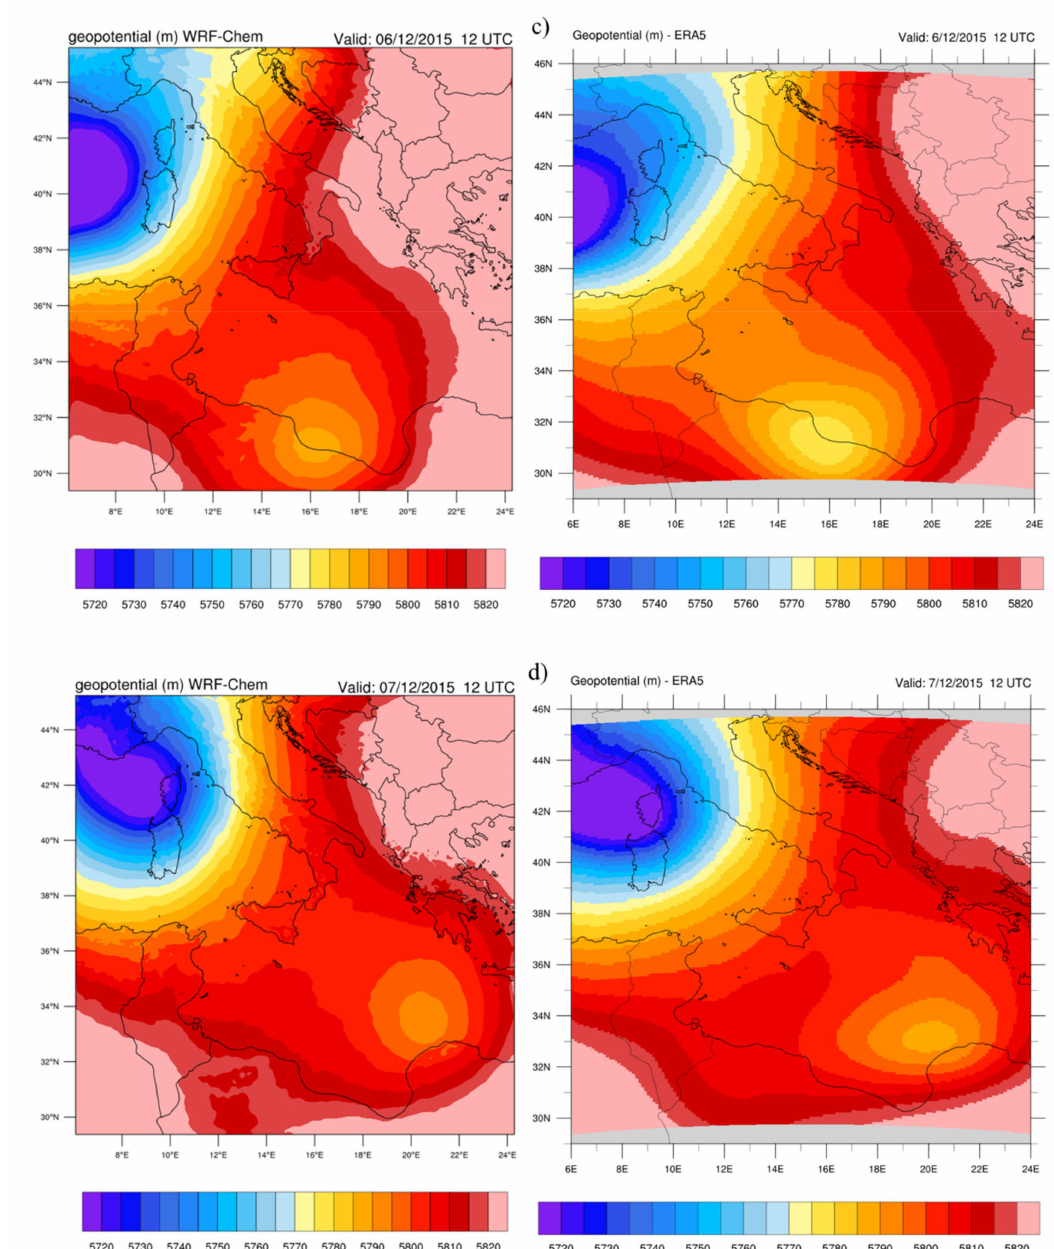
Figure 6. Geopotential height at an atmospheric pressure of 500 hPa checked on four days: ( a ) December 4th, ( b ) December 5th, ( c ) December 6th, and ( d ) December 7th. Left panels: output from WRF–Chem simulations. Right panels: observed data from ERA5—ECMWF website